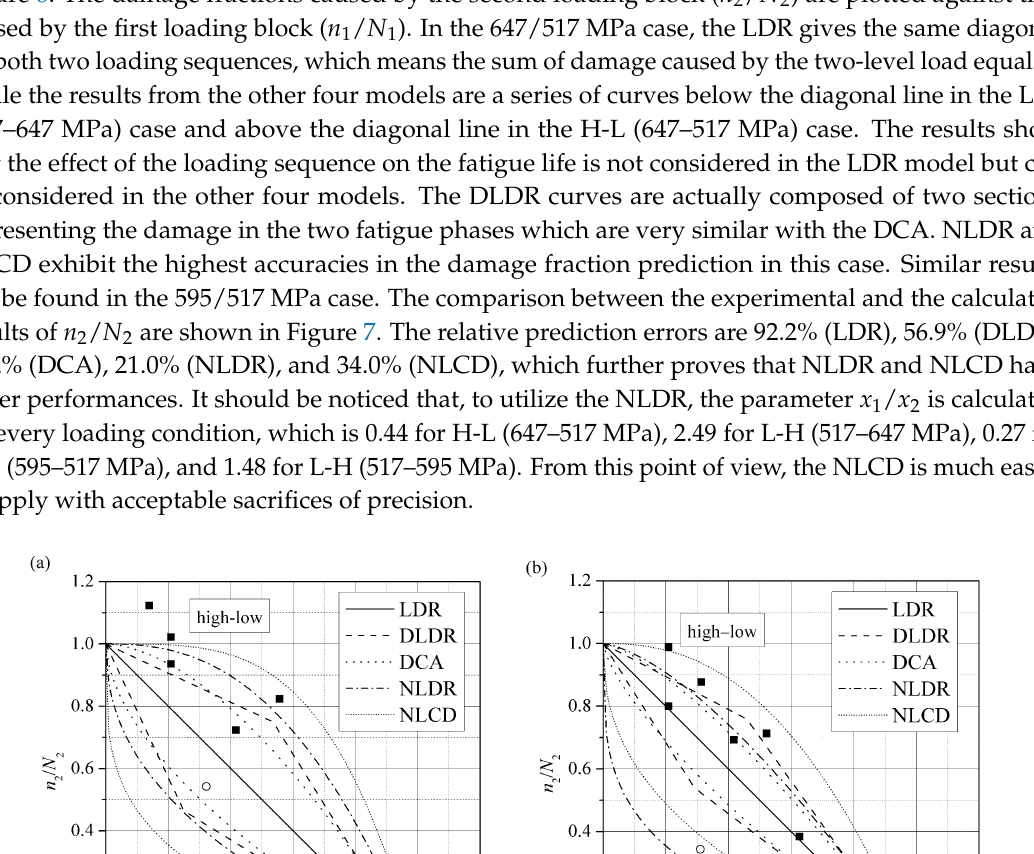
Figure 7. Relative errors of predicted n 2 .